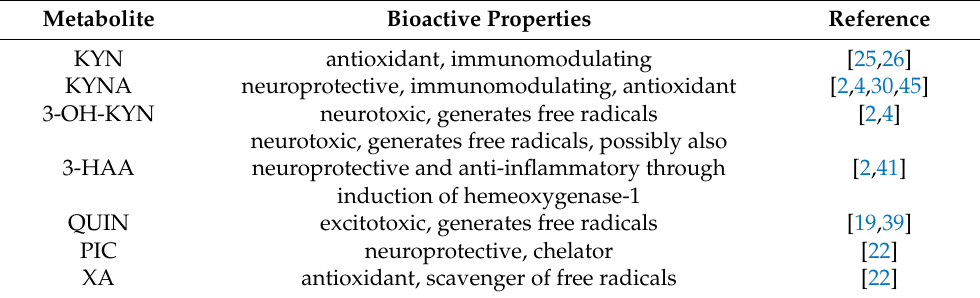
Table 1. The major effects of selected Trp–KYN pathway metabolites. 3-HAA: 3-hydroxyanthranilic acid; KYN: kynurenine; KYNA: kynurenic acid; QUIN: quinolinic acid; PIC: picolinic acid; XA: xanthurenic